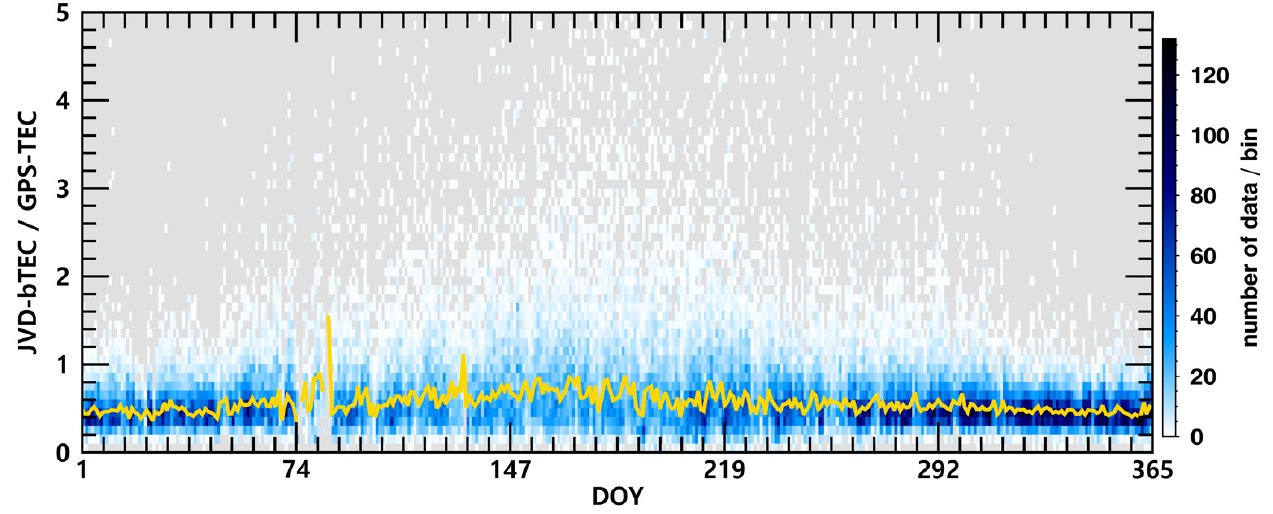
Figure 4. The annual variation in the ratios of JVD bTECs to GPS VTECs averaged for 10 min during the period of 2017 to 2019. The yellow line indicates daily median values, and the bluish colors indicate the numbers of data in each bin.